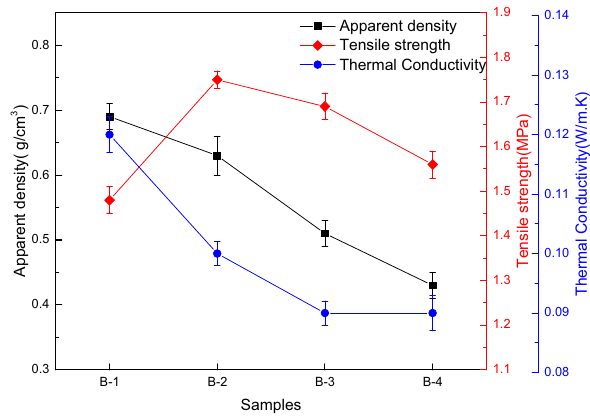
Figure 8: Physical, mechanical, and thermal insulation properties of